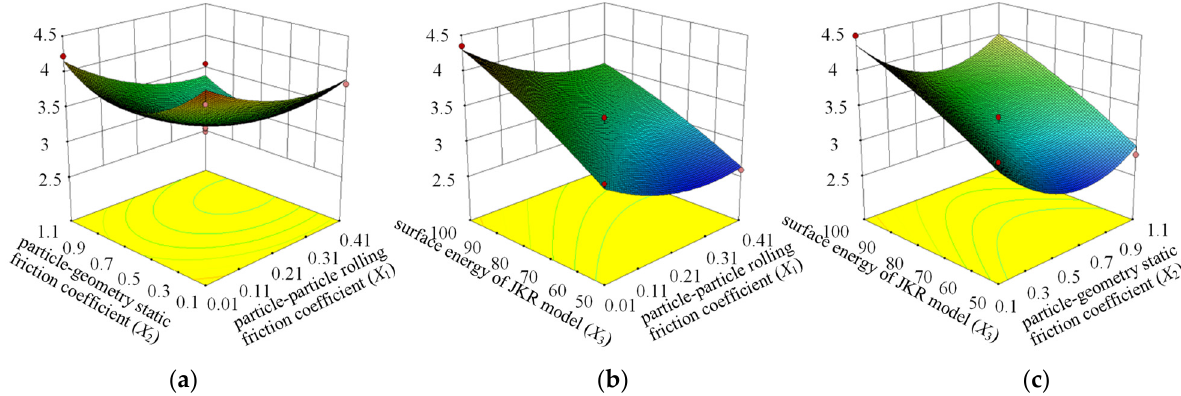
Figure 5. Interaction between parameters affecting soil adhesion mass: ( a ) interaction between X 1 and X 2 ; ( b ) interaction between X 1 and X 3 ; ( c ) interaction between X 2 and X 3 .